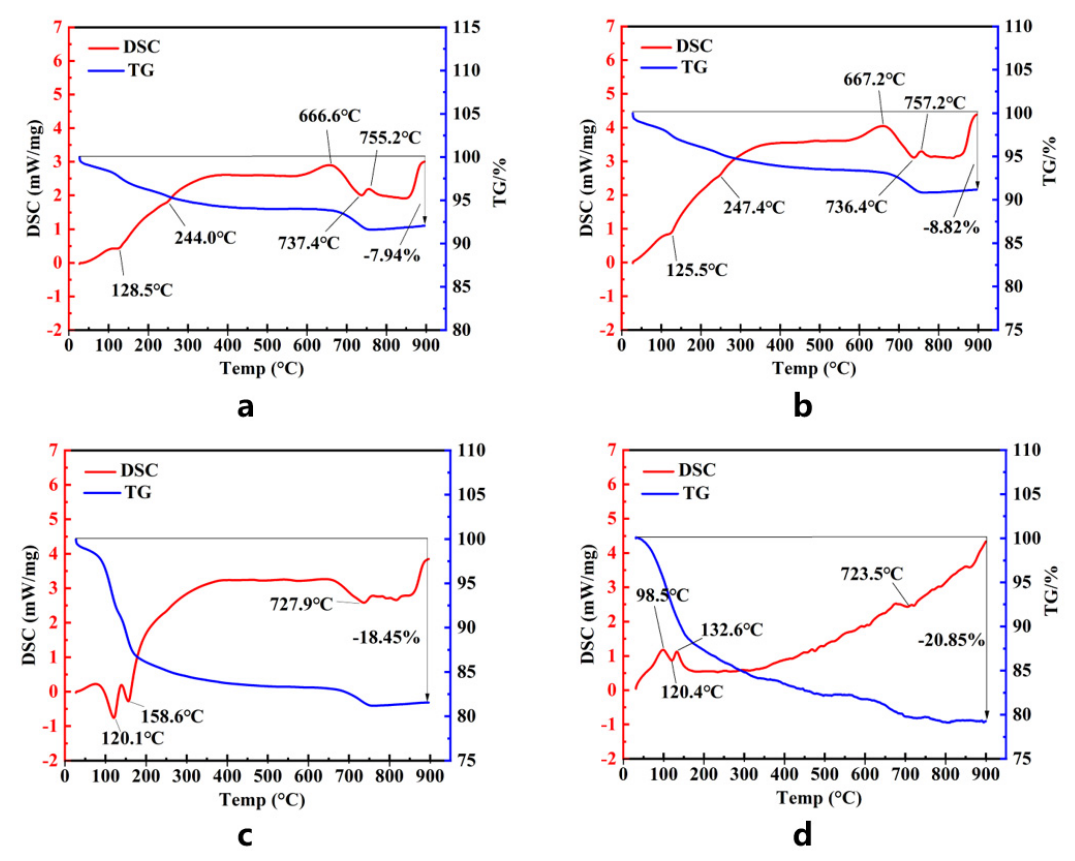
Figure 8. TG-DSC test results of 3 d ( a ), 7 d ( b ), 28 d ( c ), 56 d ( d ). Table 7. Leaching toxicity test